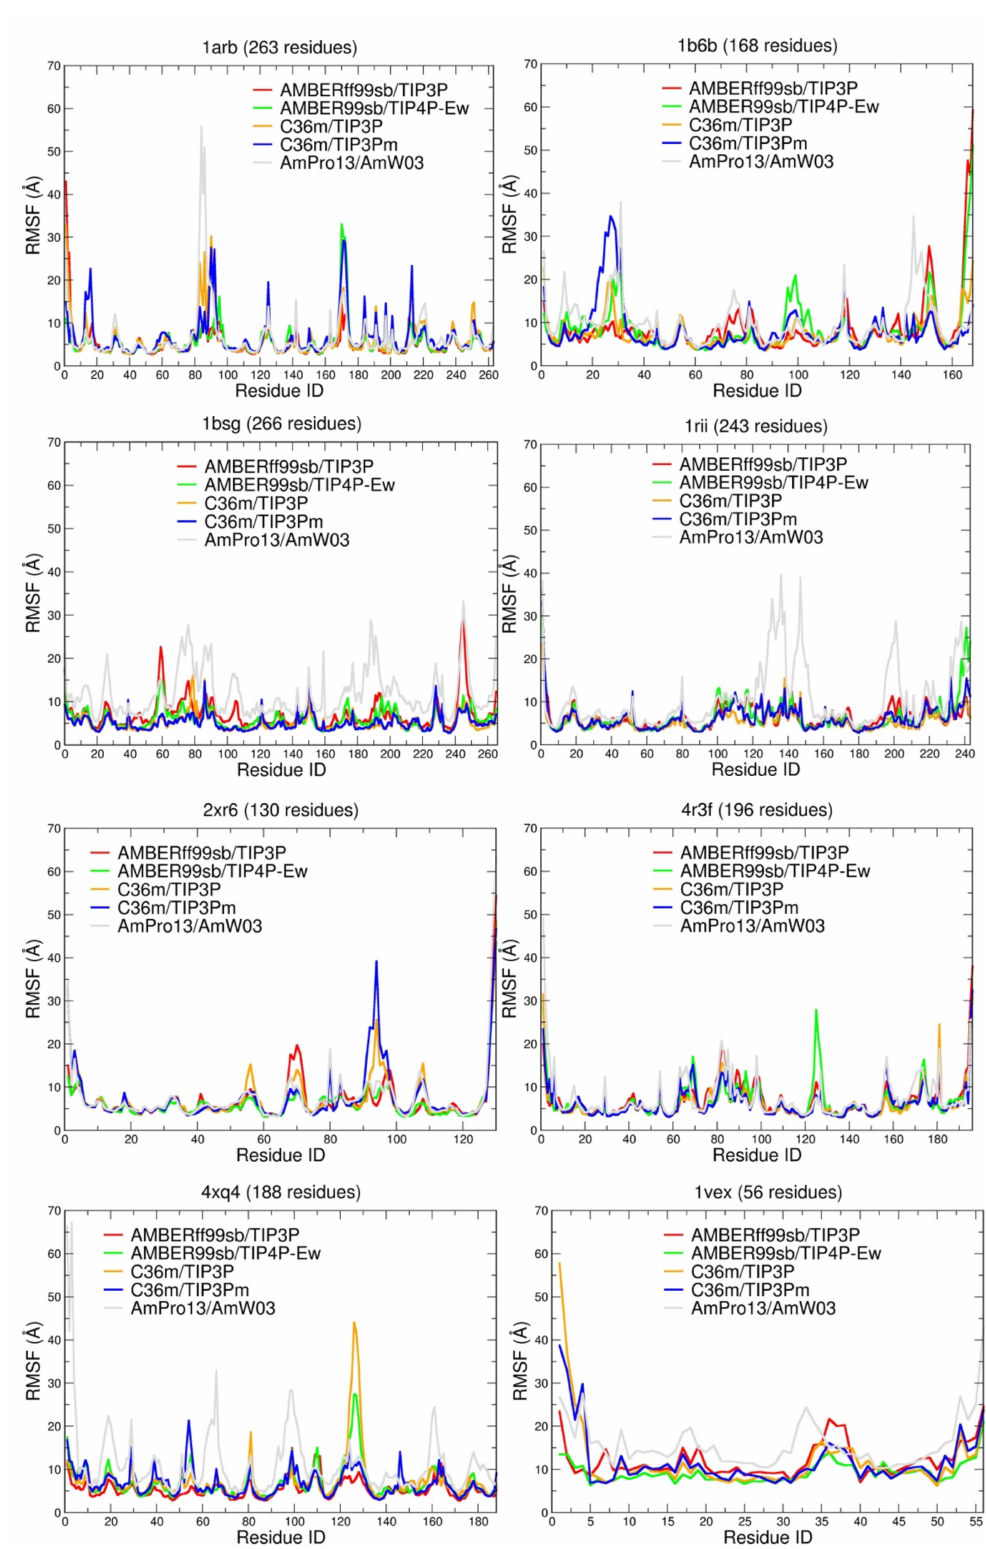
Figure 3. Average root mean square fluctuation for each residue in the simulated trajectories averaged over the last 100 ns. For 1arb [38] 1b6b [37], 1bsg [39], 1rii [40] 4xq4 [43], 4r3f [42] and 2xr6